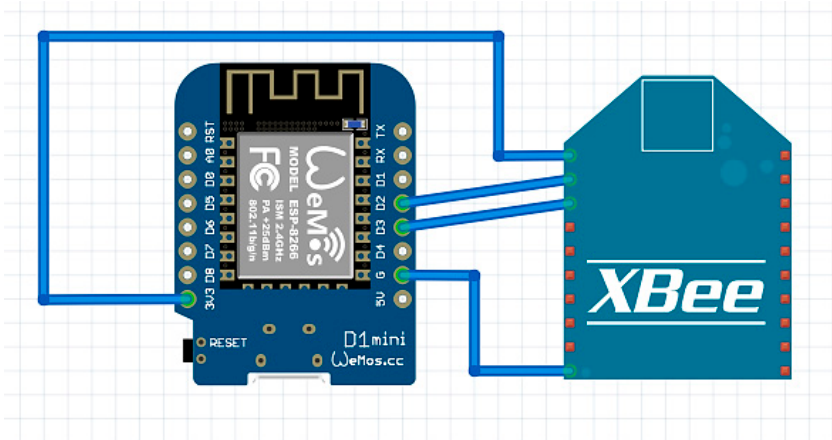
Figure 8. iAQ Gateway.